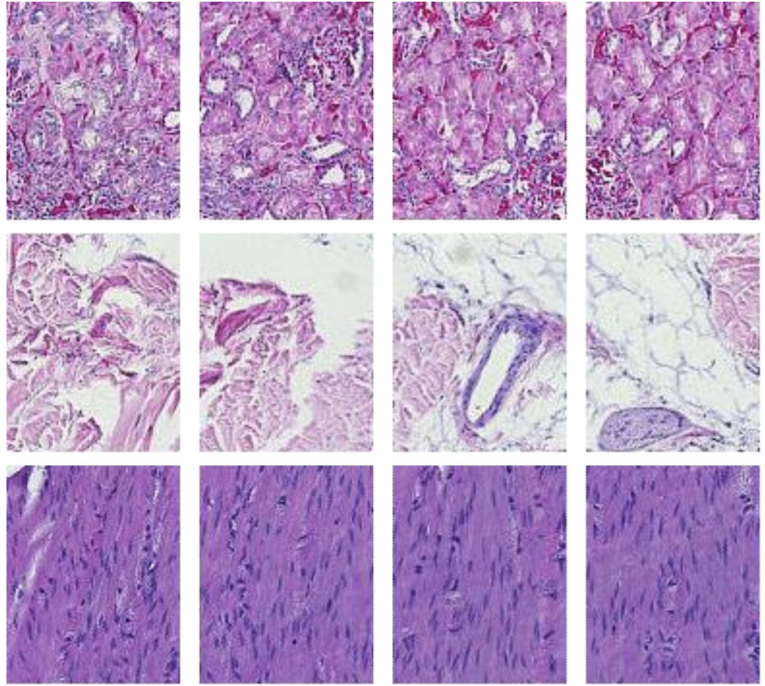
Figure 7. For illustration purposes, three tiled ROIs from three laboratories (per row). The first row is kidney, the second is skin, and the last is